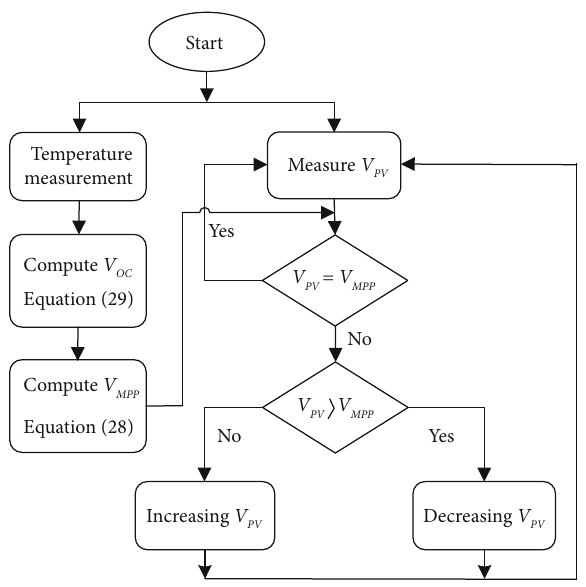
Figure 10: Flowchart of the modi fi ed FOCV MPPT method.